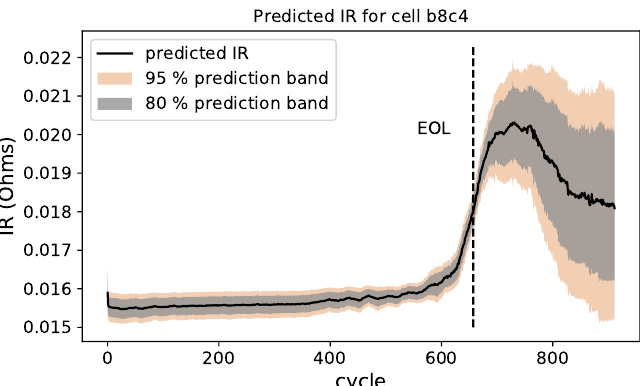
Figure 2. The predicted IR data for cell b8c4 are given by the black continuous line and is formed from the average of 20 predictions. We display 80% and 95% prediction intervals. Beyond the intuition of extrapolation, these intervals show that predictions past the EOL (capacity) should not be trusted.